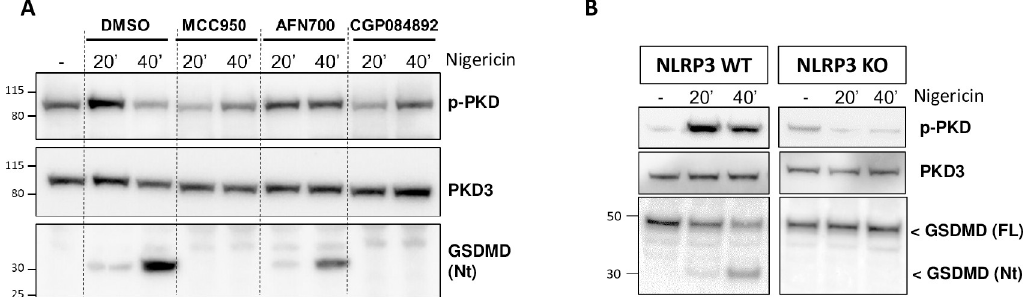
Fig 3. NLRP3 blockade prevents PKD auto-phosphorylation. (A) Immunoblot analysis of whole cell lysates from THP-1 cells treated with nigericin for the indicated times ± MCC950 (1 μ M), AFN700 (3 μ M) or CGP084892 (20 μ M), monitoring total PKD3 as well as auto-phosphorylated PKD and gasdermin D cleavage. (B) Immunoblot analysis of whole cell lysates from THP- 1-WT or NLRP3-KO cells treated with nigericin for the indicated times, auto-phosphorylated PKD, as well as full and N- terminally cleaved gasdermin